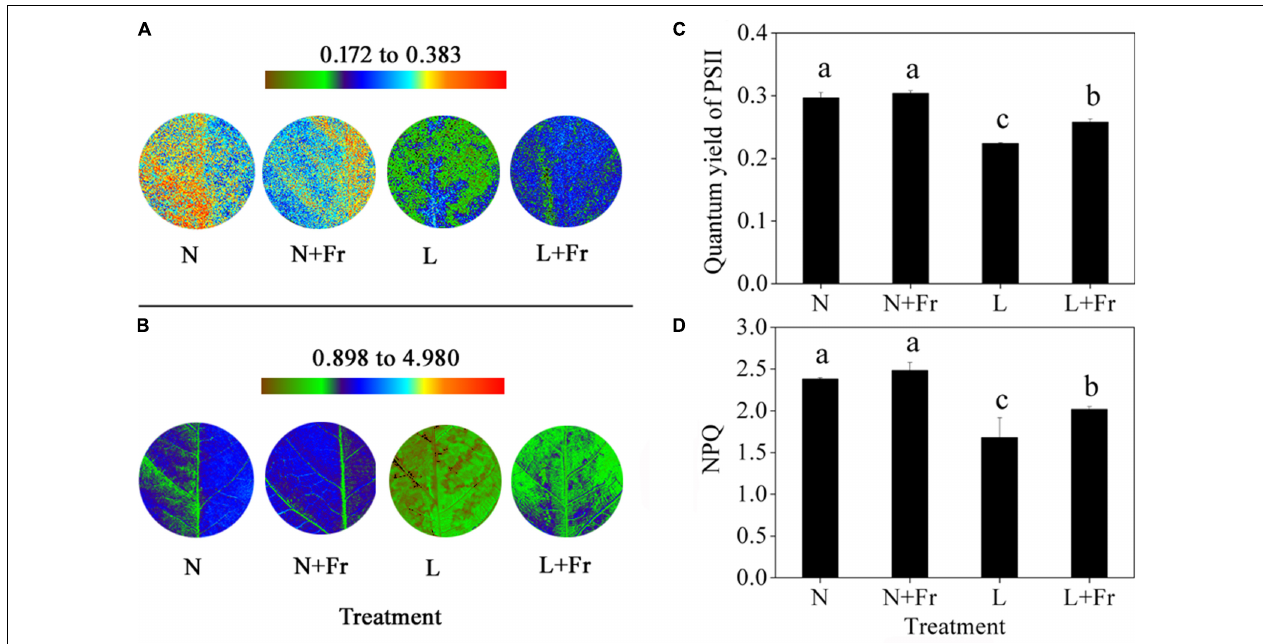
FIGURE 4 | Quantum yield of PSII (A,C) and NPQ (B,D) of Chl fluorescence under different light intensity and quality treatments. Chl fluorescence images (A,B) were captured from a single plant in each treatment. The false color code depicted at the top of each image ranges from brown to red. N, N+Fr, L, and L+Fr denote normal light (normal PAR and normal R/Fr ratio), normal light plus far-red light (normal PAR and low R/Fr ratio), low light (low PAR and normal R/Fr ratio), and low light plus far-red light (low PAR and low R/Fr ratio), respectively. Each value is expressed as the mean ± SE. The means for each treatment that do not have a common letter are significantly different at P = 0.05, according to Duncan’s multiple range test.